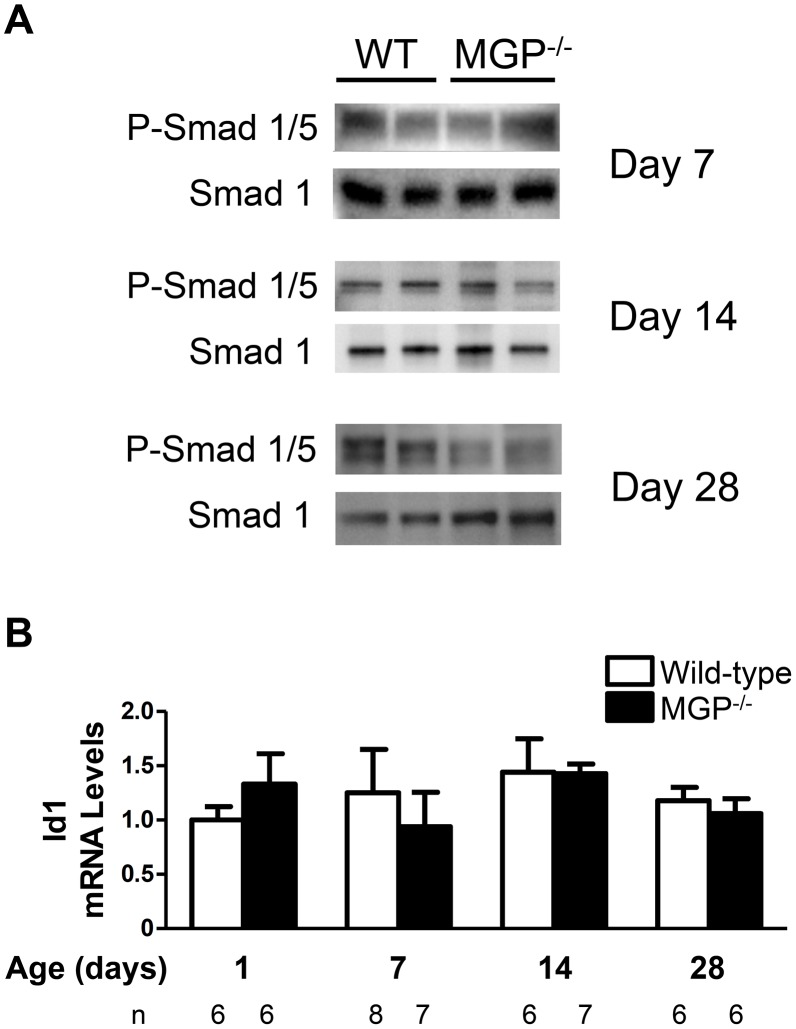
BMP signaling is not increased in aortas of MGP-/- mice.(A) Protein lysates were isolated from the aortas of 7-, 14-, and 28-day-old WT and MGP-/- mice. Each lane represents protein isolated from four pooled aortas. PVDF membranes were incubated with antibodies directed against phosphorylated Smad 1/5 (P-Smad 1/5) and total Smad 1. The ratio of P-Smad 1/5 to total Smad 1 was the same in aortas derived from WT and MGP-/- mice. (B) RNA was isolated from aortas of WT and MGP-/- mice at 1, 7, 14, and 28 days of (n = 6–8 in each group, as indicated). No difference in aortic Id1 mRNA levels was observed between MGP-/- and WT mice.